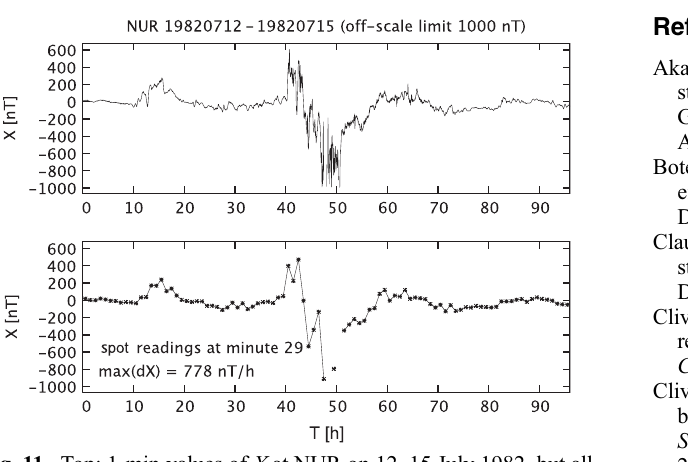
Fig. 11. Top: 1-min values of X at NUR on 12–15 July 1982, but all variations exceeding 1000 nT assumed to be missing. Bottom: 1-h time series by spot readings at minute 29, which now gives the largest d X /d t (cf. Fig. 2).